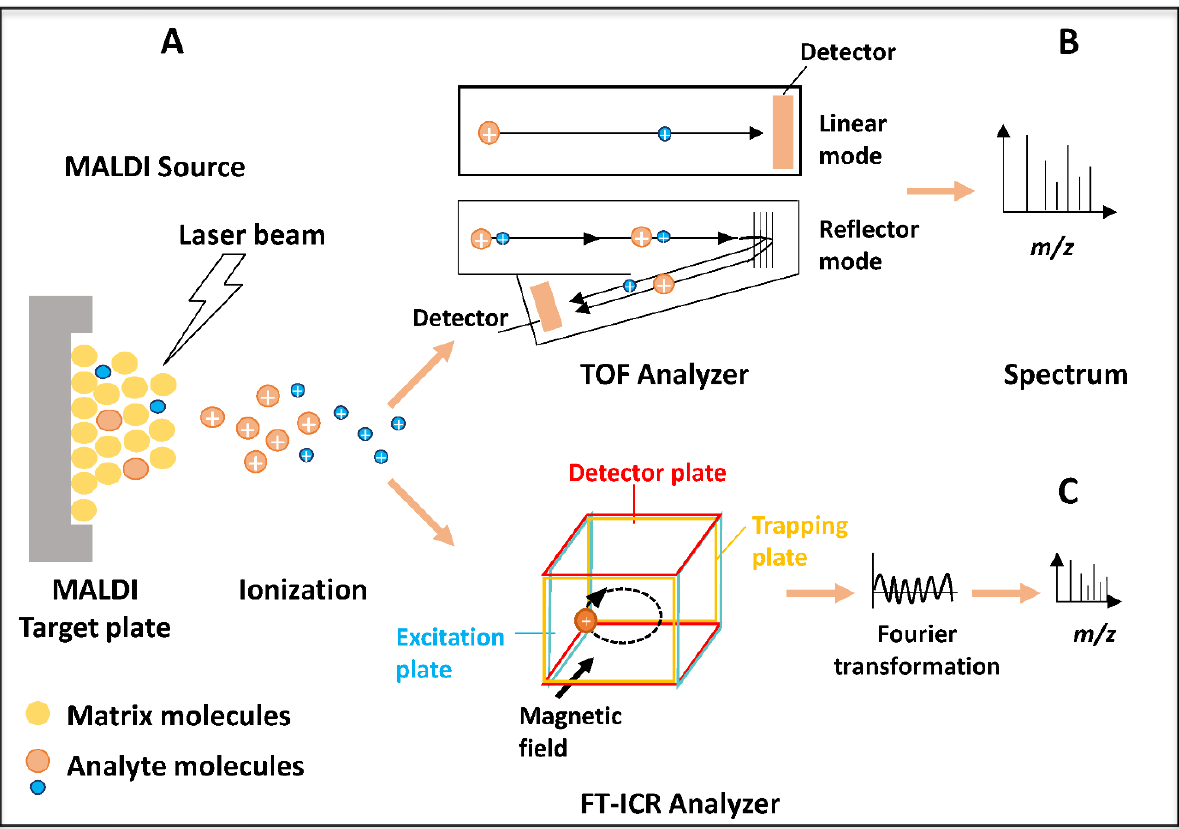
Figure 1. Schematics of the MALDI-MS preparation and the equipment used for SARS-CoV-2 detection. In the sample preparation step, analytes are mixed with a large excess of matrix and are spotted onto a stainless steel target plate, where they co-crystallize. In the MALDI source, ( A ) the co-crystals are irradiated with a laser beam, inducing the desorption and ionization of analytes. The generated ions are accelerated in an electric field, which directs them to the analyzer. In the TOF analyzer, ( B ) ions are separated according to their m / z in a flight tube by two different modes: linear and reflectron. The ions are accelerated toward a detector, which amplifies ion signals and converts them into a mass spectrum. In the FT-ICR analyzer, ( C ) the m / z are measured according to the cyclotron frequency of the ions, trapped in a circular orbit, and subjected to a magnetic field, subsequently generating a signal. Using a Fourier transform, the signal is converted into a mass spectrum. The MALDI mass spectrum represents the mass-to-charge ratios of each ionized molecular species in a sample.